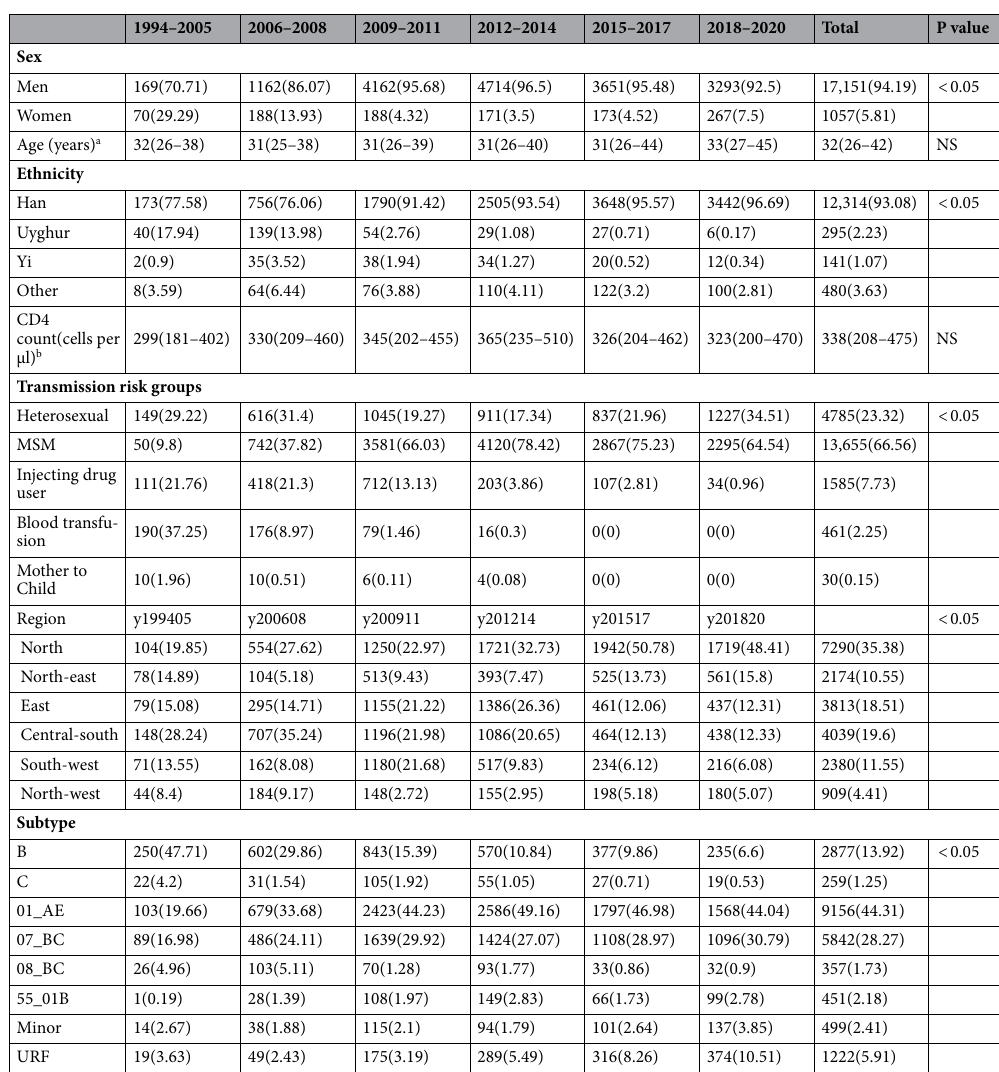
Table 1. Baseline characteristic by sampling phase. Data are n (%), or median (IQR). MSM, men who have sex with men; URF, unique recombinant form. North, Beijing, Tianjin, Hebei, Shanxi, and InnerMongolia.